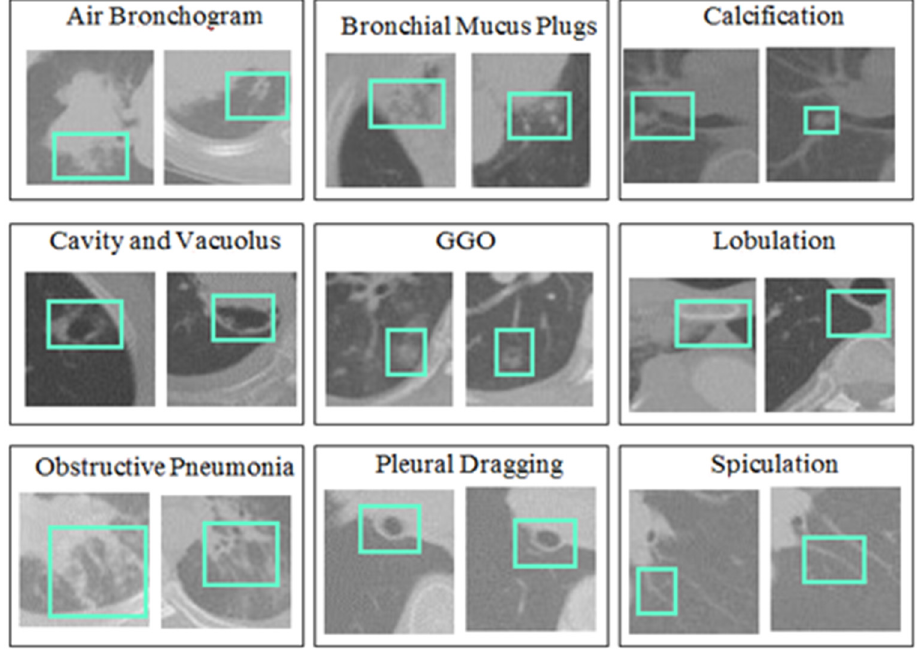
Figure 5. Abnormal signs in LISS dataset .